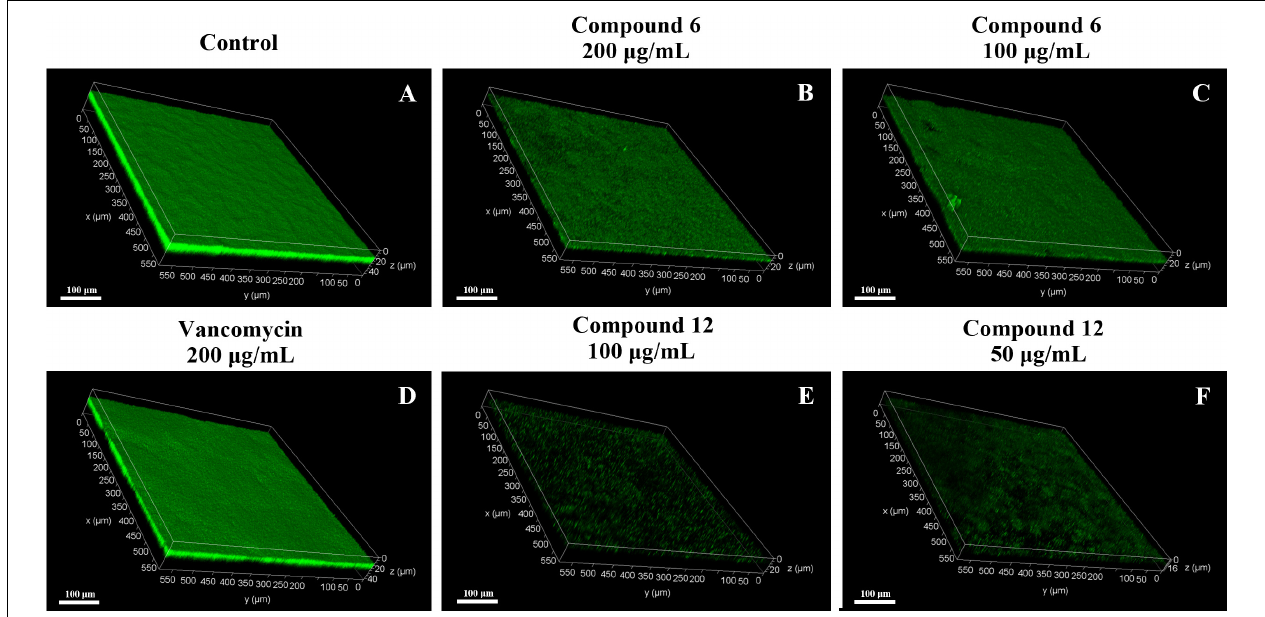
FIGURE 7 | Confocal scanning laser micrographs of 24-h preformed MRSA biofilms treated with different concentrations of compounds 6 and 12 . (A–F) Different treatment groups ( A DMSO control; B 200 µ g/ml of compound 6 ; C 100 µ g/ml of compound 6 ; D 200 µ g/ml of vancomycin; E 100 µ g/ml of compound 12 ; F 50 µ g/ml of compound 12 ). Scale bars represent 100 µ